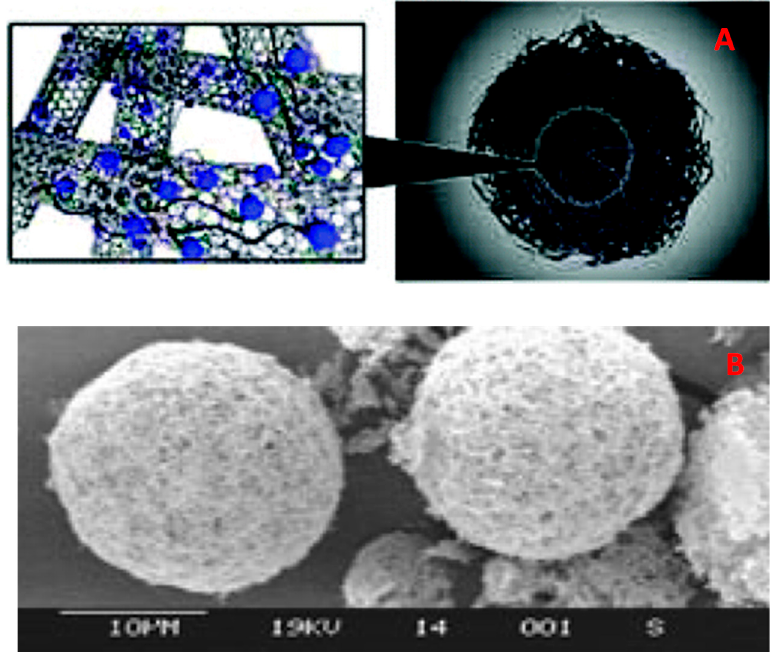
Figure 18. SEM image of (surfactant-mediated) self-assembled carbon nanotubes (CNTs) microspheres ( A ). Adapted with permission from ref. [212]. Copyright (2011) American Chemical Society.